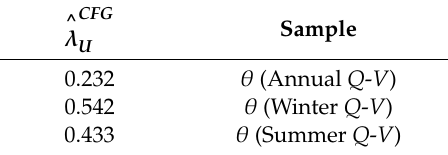
Table 10. Estimated values for ˆ λ CFG